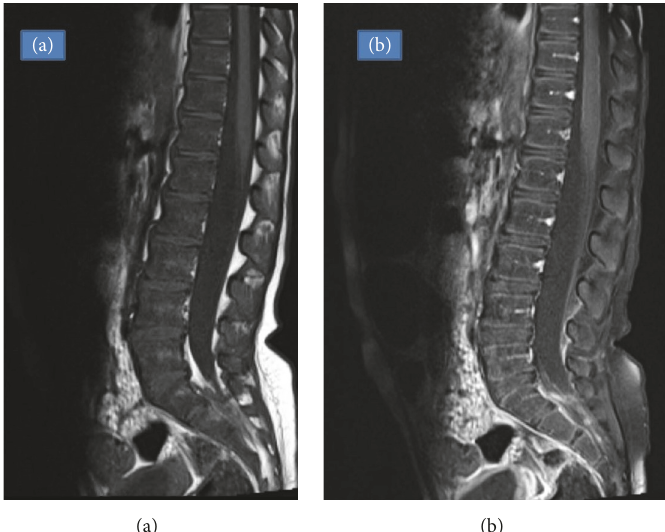
Figure 4: Sagittal T1-weighted image (a) and sagittal postcontrast T1-weighted image with fat suppression (b) show a significant tumor mass volume reduction after